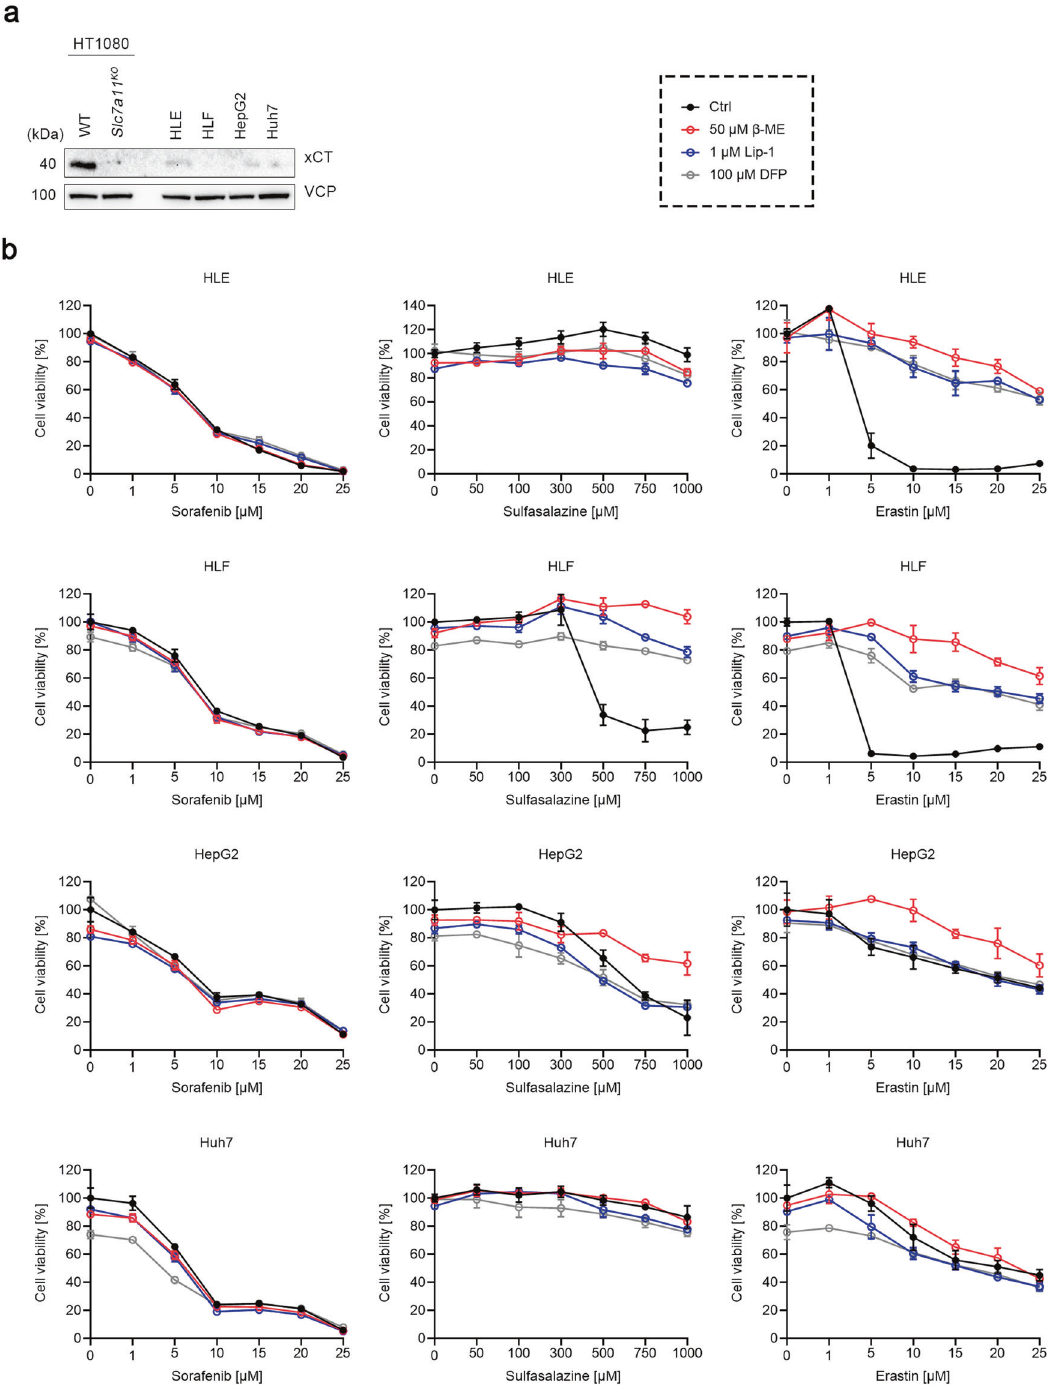
Fig. 6 Sorafenib does not cause ferroptosis in human hepatoma cell lines. a Immunoblots of xCT in WT HT1080, SLC7A11 KO HT1080, and HLE, HLF, HepG2, Huh7 hepatoma cells. VCP was used as a loading control. b Cell viability of HLE, HLF, HepG2, and Huh7 cells treated with indicated concentrations of sorafenib, sulfasalazine, or erastin, in the absence or presence of 50 μ M β -ME, 1 μ M Lip-1, or 100 μ M DFP for 24 h. Data are presented as mean ± s.d. of n = 3 wells of a 96-well plate from one representative of three independent experiments.